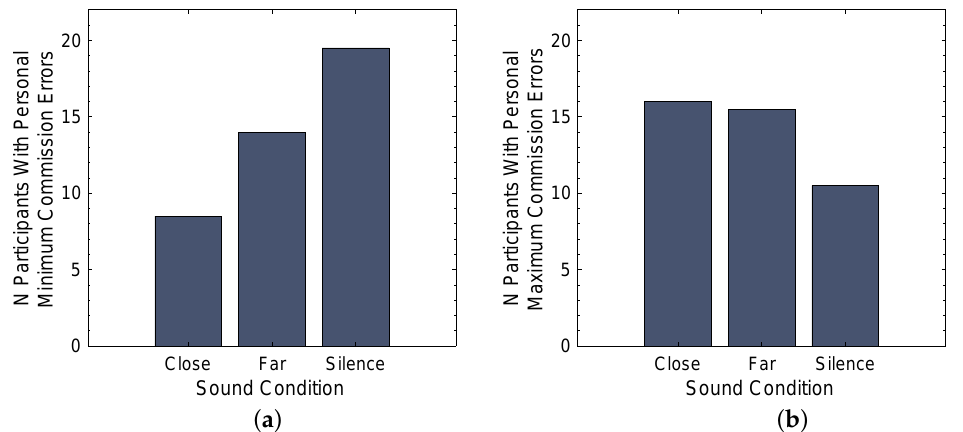
Figure 8. Number of participants with personal minimum ( a ) and maximum ( b ) number of commis- sion errors for each sound